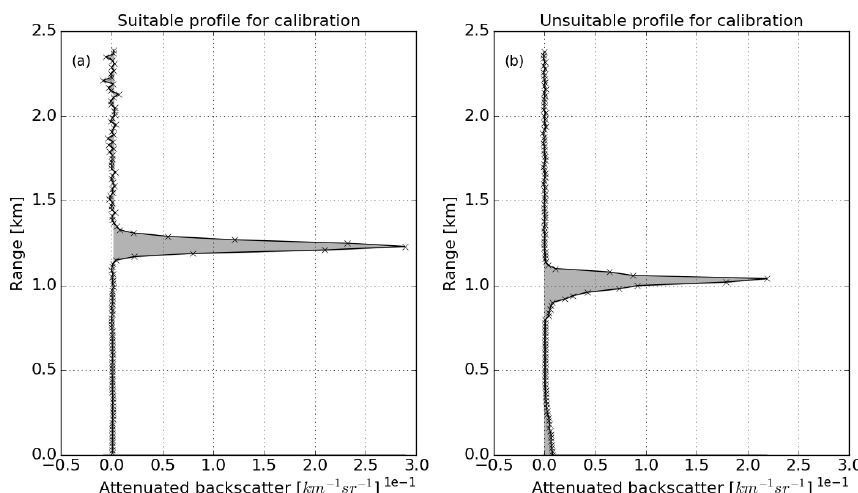
Figure 2. Profiles of attenuated backscatter through stratocumulus cloud. Panel (a) shows an example of a suitable profile for calibration. The integral of the profile (grey shaded area) is equal to 1 and, when calibrated, should give an S of 18 . 8 ± 0 . 8sr. Panel (b) shows an 2 ηS example of a profile unsuitable for calibration due to the high levels of aerosol in the first 200m, indicated by the grey shading up to 200m, and due to the drizzle below the stratocumulus cloud, indicated by the slight increase in attenuated backscatter underneath the peak.